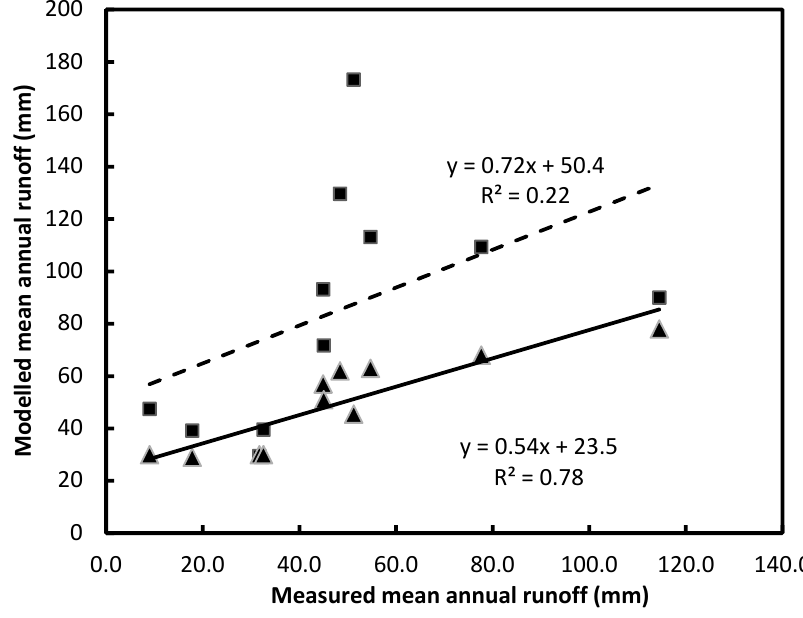
Figure 4. Comparison of runoff estimated from the Guswa-based model ( ▲ ) and Choudhury ‘default’ model ( ■ ) for eleven catchments in south-west Western